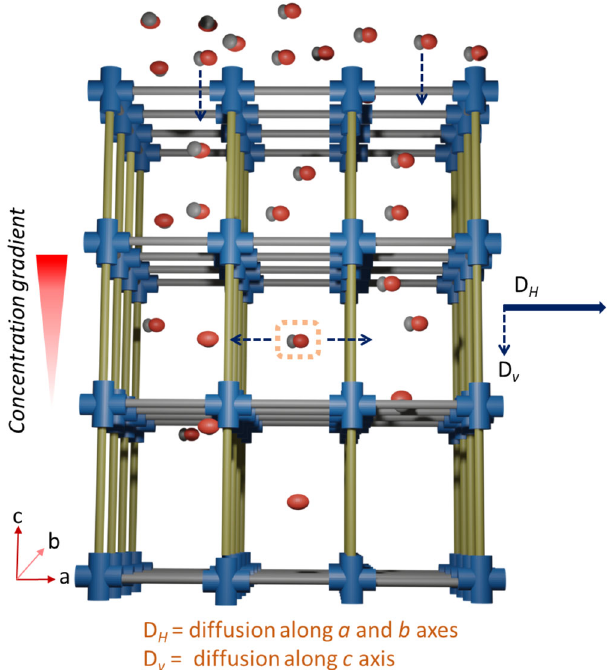
Fig.1|MoleculardiffusioninMOF. Anillustrationofthemoleculardiffusionalong the concentration gradient ina crystalline, porous structure, inwhich mass uptake is controlled by the pore windows orthogonal to the concentration gradient; (molecules are methanol, presented in space fi ll model, O=red, C=gray); con- centration gradient is along c -axis. Color code: blue Cu-paddle-wheel, gray BDC linker, yellow pillar